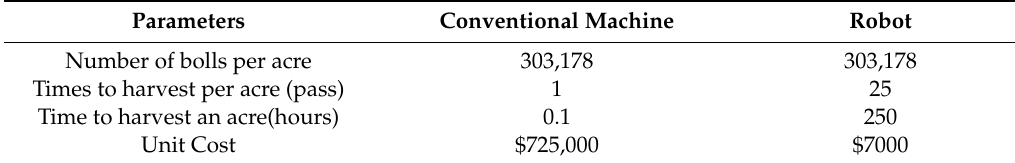
Table 1. Comparison of the conventional machine and robot for cotton